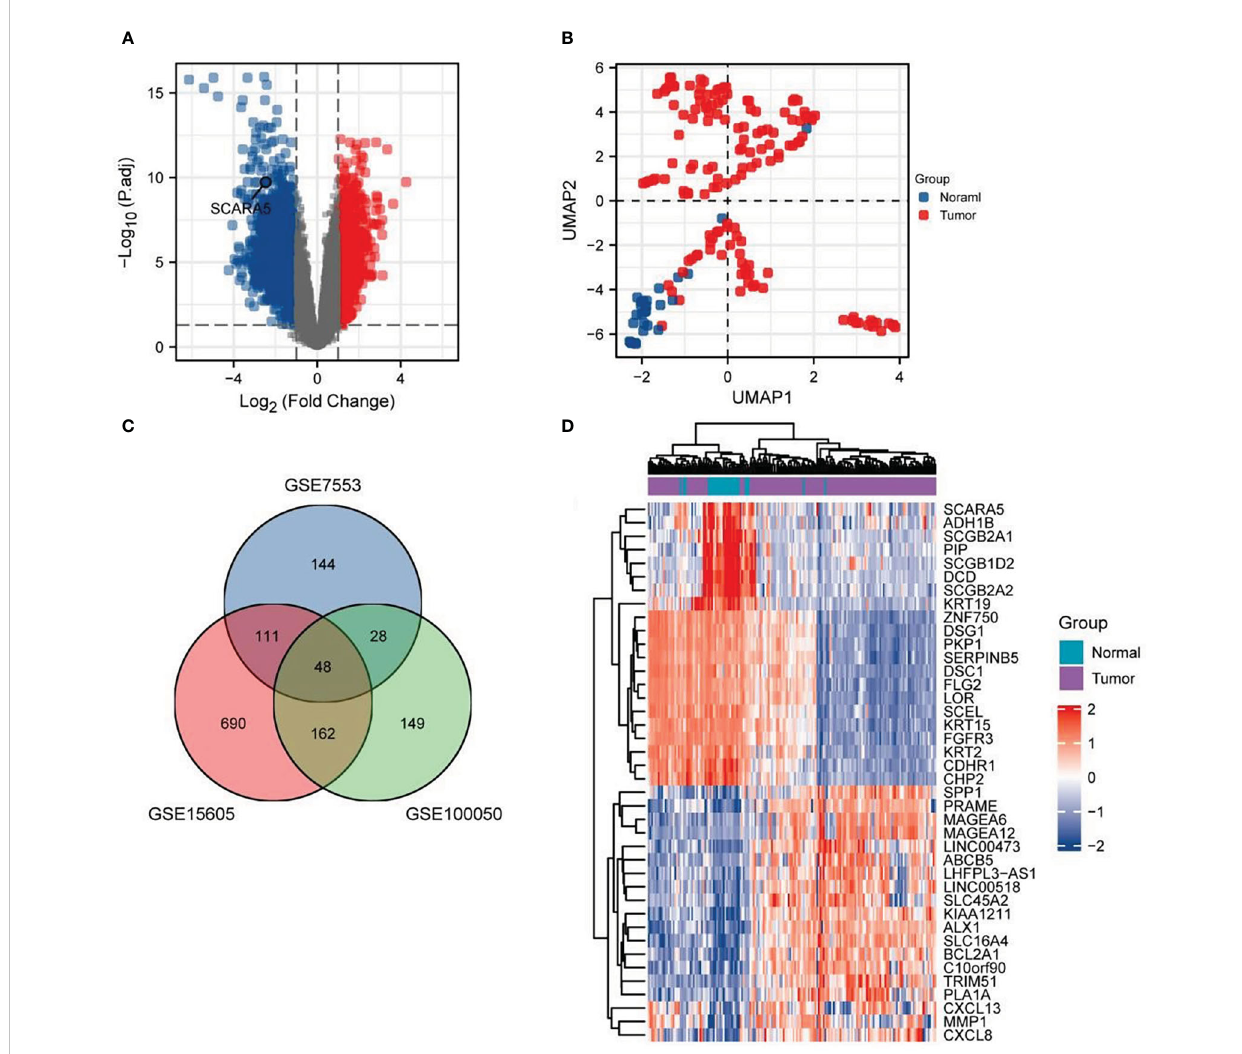
FIGURE 1 Difference analysis. Volcano plots were used to select differential genes with a threshold o fl og FC ≥ 1 and a p -value ≤ 0.05. Firstly, the differentially expressed gene (DEG) is analyzed by the “ Limma ” software package, the classic volcano diagram is presented in the form of a volcano diagram, and the location of scavenger receptor class A member 5 ( SCARA5 ) is marked (A) . Two groups of samples are separated, indicating that the differences between groups is signi fi cant, and the subsequent difference analysis is meaningful (B) . There are 48 DEGs in the three data sets, comprising nine downregulated and 39 upregulated genes (C) . Using the differential expression analysis tool DESeq2, we analyzed the top 20 upregulated and downregulated genes in both cancer tissues and adjacent normal tissues (D)